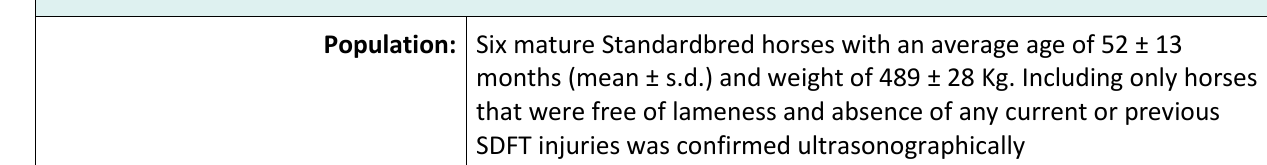
Population: Six mature Standardbred horses with an average age of 52 ± 13 months (mean ± s.d.) and weight of 489 ± 28 Kg. Including only horses that were free of lameness and absence of any current or previous SDFT injuries was confirmed